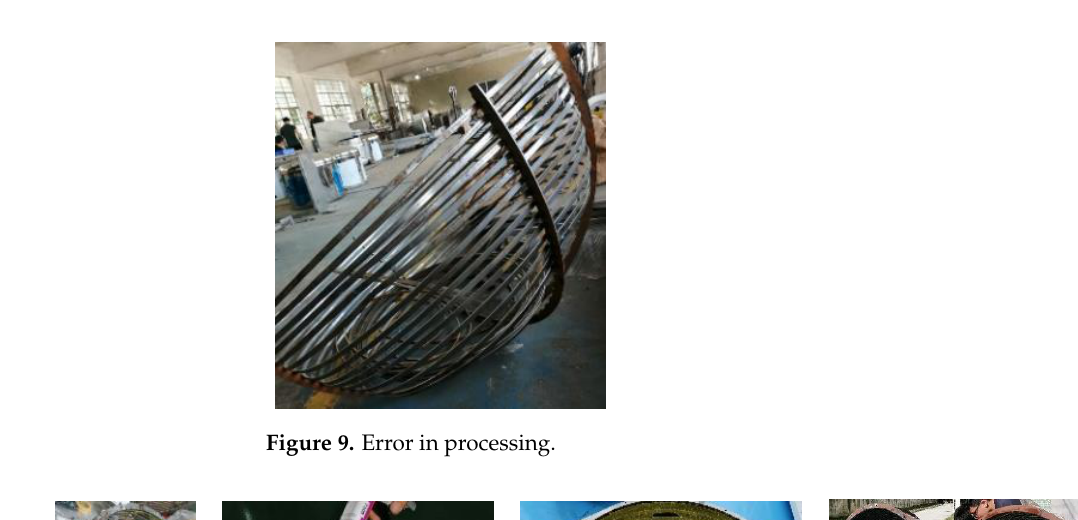
( b ) Figure 8. The finished powersphere frame: ( a ) the hemisphere frame, ( b ) the ball frame. During the manufacturing experiment, because the thickness of the iron ring is too large, the number of 1/4-round workpieces is not enough, and the arc of the iron ring between two 1/4-round workpieces is not round enough, as shown in Figure 9. This re- quires manual adjustment of the roundness of the iron ring, which causes processing er- rors and affects the light uniformity of the powersphere. In the future manufacturing, some measures can be taken to reduce the error, such as reducing the thickness of the material, increasing the number of 1/4-round workpieces, and dividing the iron ring into multiple short arc-shaped workpieces followed by welding. In the manufacturing exper-